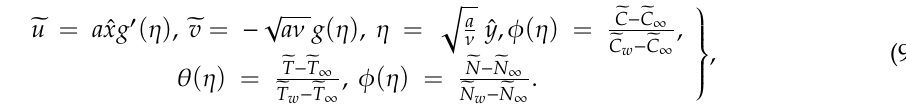
e ff ected heat capacitance of the nanoparticle to the base-fluid (cid:101) τ = parametric